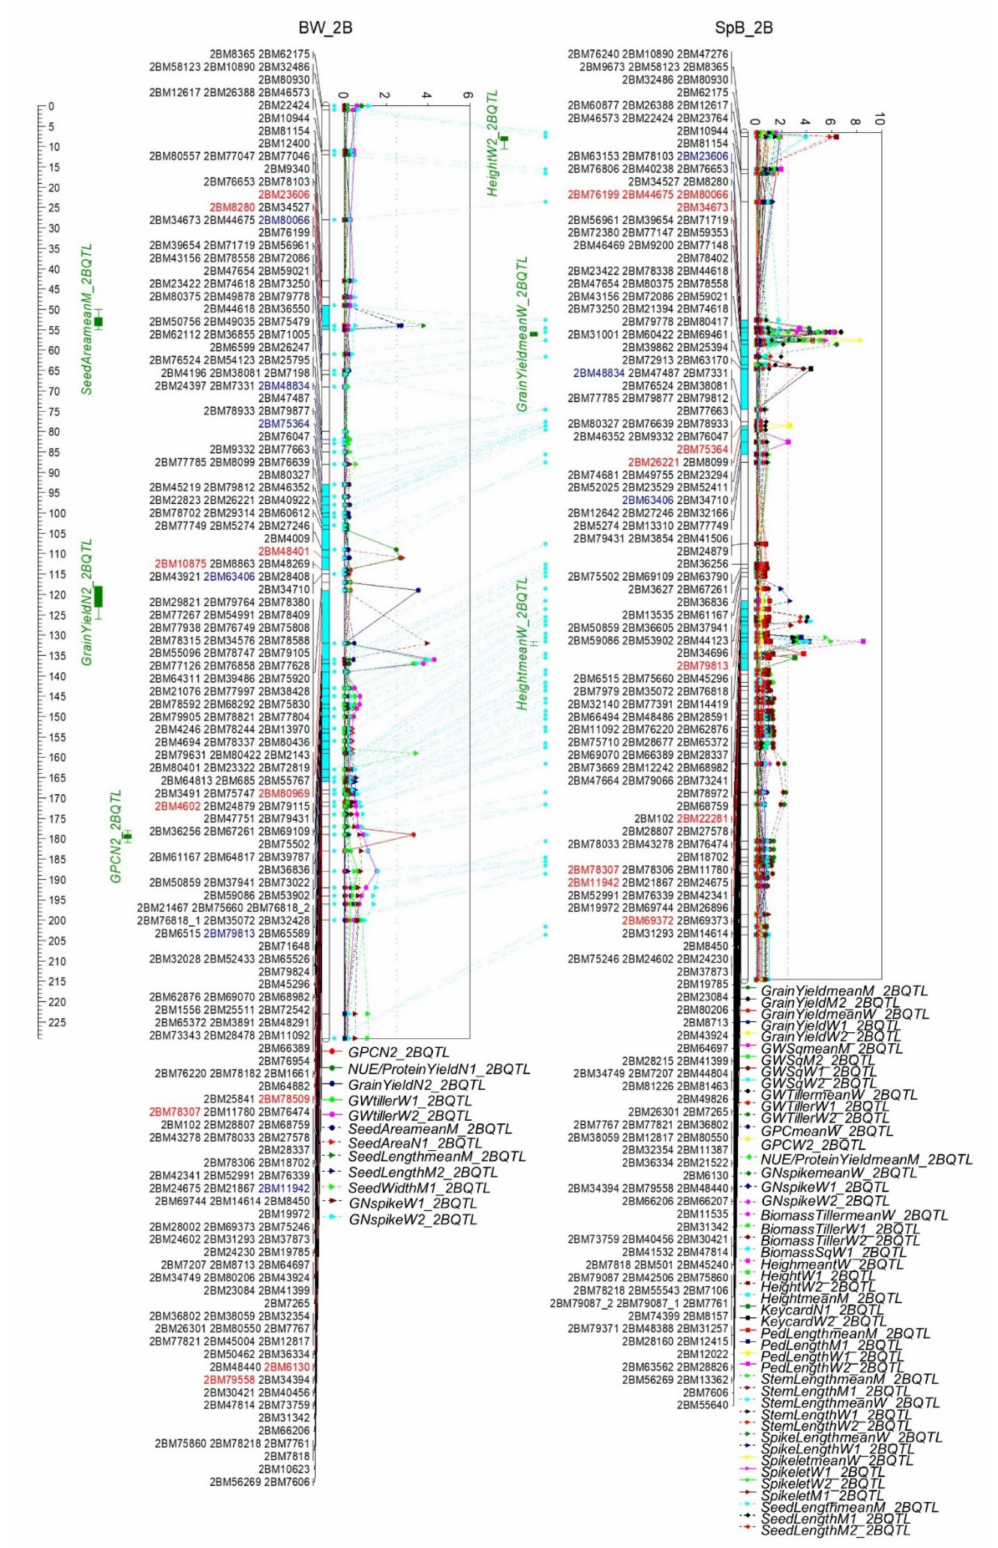
Figure 7. Significant QTL formed three QTL clusters on the homologous regions on 2B in BW and SpB populations. Homologous regions in both populations are highlighted in light blue; markers for QTL highlighted in red; homologous markers in